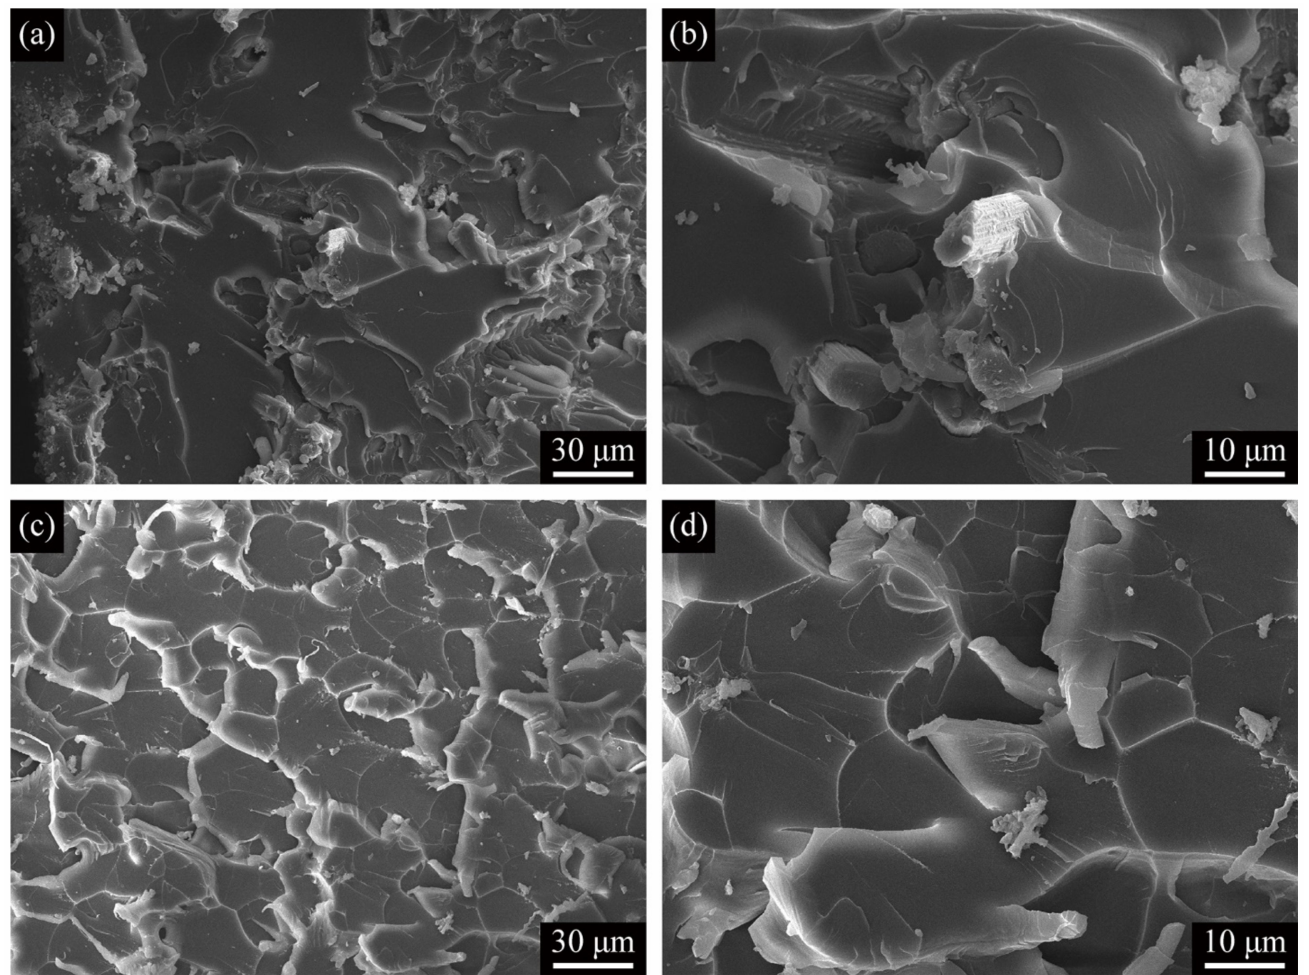
Figure 6. ( a ) Low-magnification and ( b ) high-magnification SEM images of tensile fracture surfaces of C2/epoxy; ( c ) Low-magnification and ( d ) high-magnification SEM images of tensile fracture surfaces of